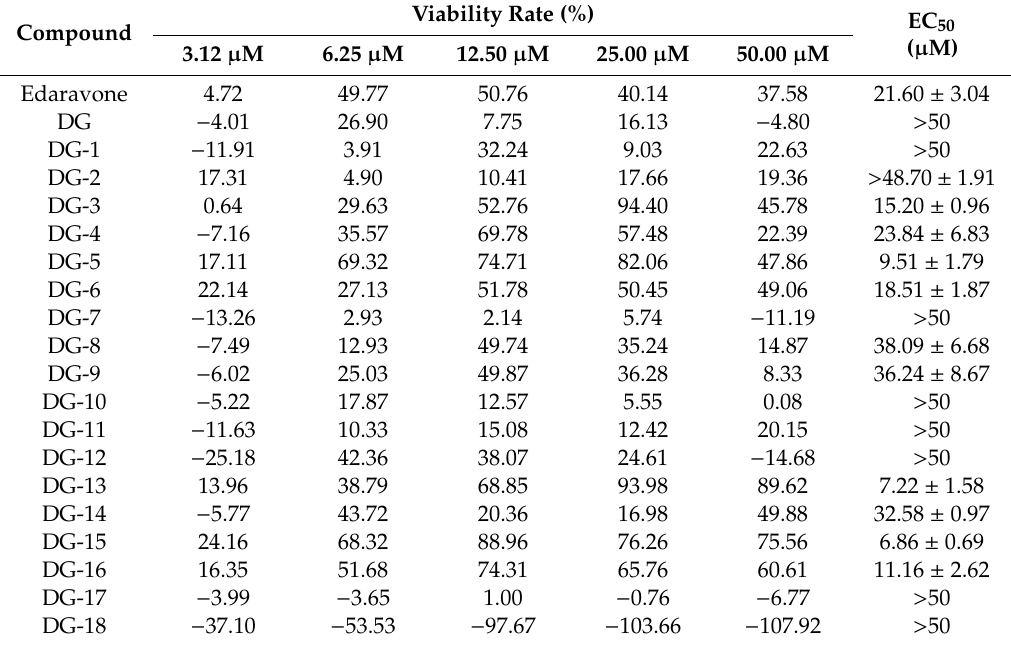
Table 2. EC 50 values of all the derivatives, raw materials and positive drug edaravone on SH-SY5Y for 24 h. Based on three independent experiments, data were expressed as viability rate ± SD ( n =